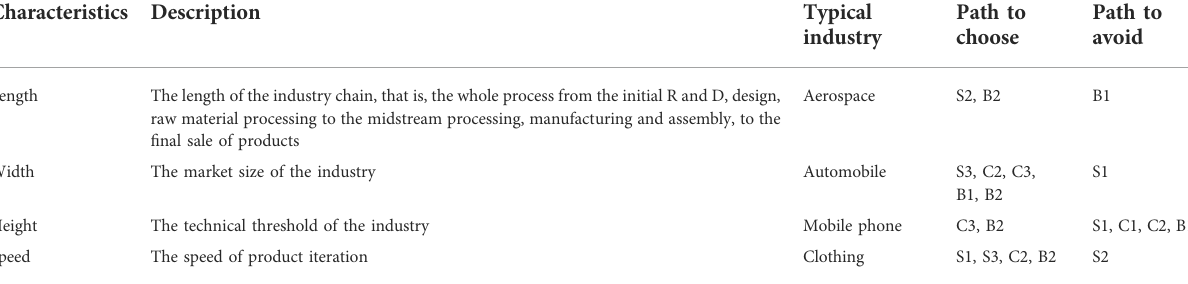
TABLE 6 Industry characteristics and recommended paths. Characteristics